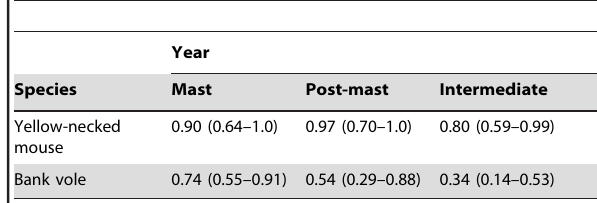
Table 2. Predicted (mean and 95% probability) contributions of mast (from oak, hornbeam, lime, spruce isotopic complex) to the diets of the yellow-necked mouse and bank vole through masting cycles assuming only a (SIAR) two-source (deciduous forest herbs vs. mast) mixing model corresponding to the depiction in Figure